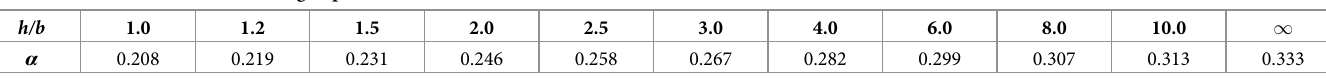
Table 2. The coefficient of the rectangle specimen under torsion load.